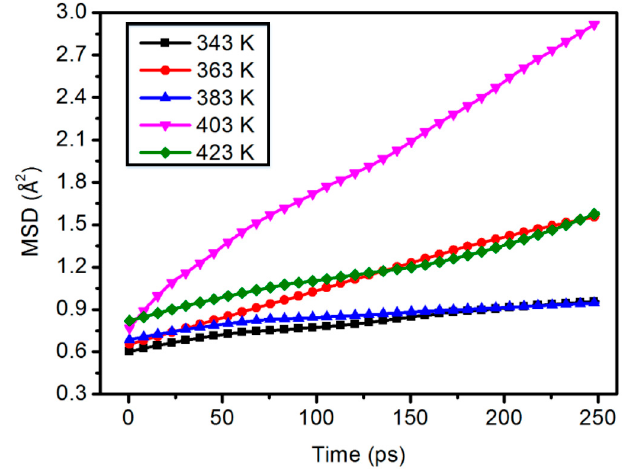
Figure 9. Chain motion of the 9.4 wt % content composite model.